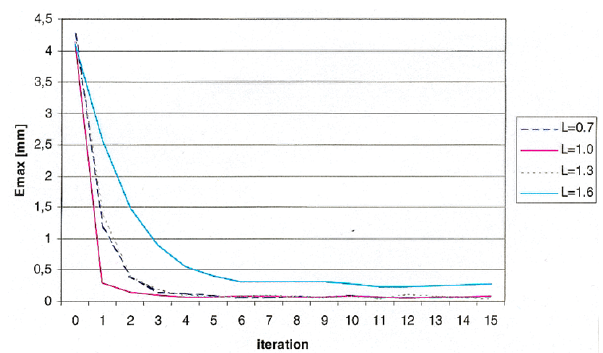
Figure 12: Iterative Learning Control (ILC) for laser- cutting of rectangular holes. The maximum path error as a function of the number of iterations at 4 different tuning levels L of the ILC.